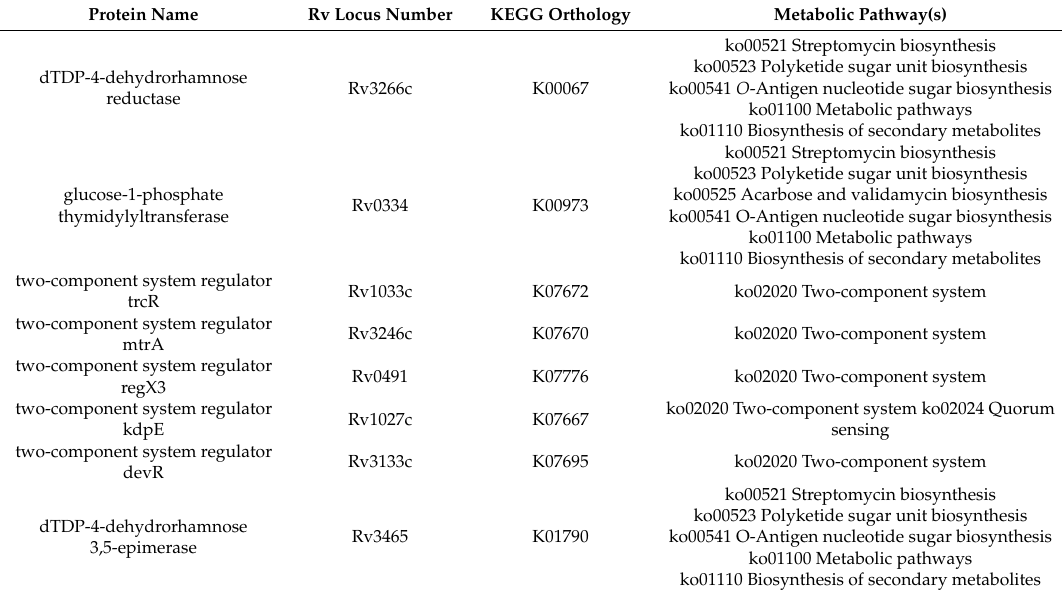
Table 1. Metabolic pathway analysis of potential drug targets.